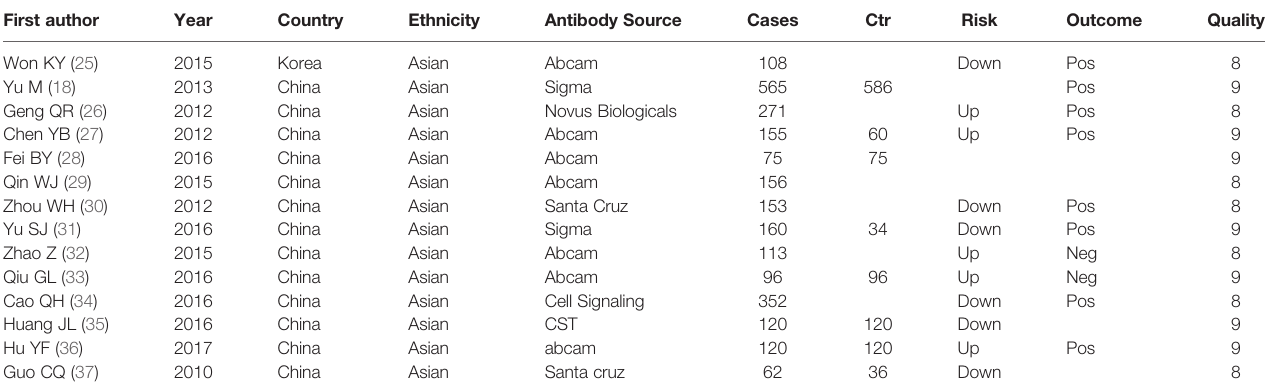
TABLE 2 | Main characteristics of eligible studies.